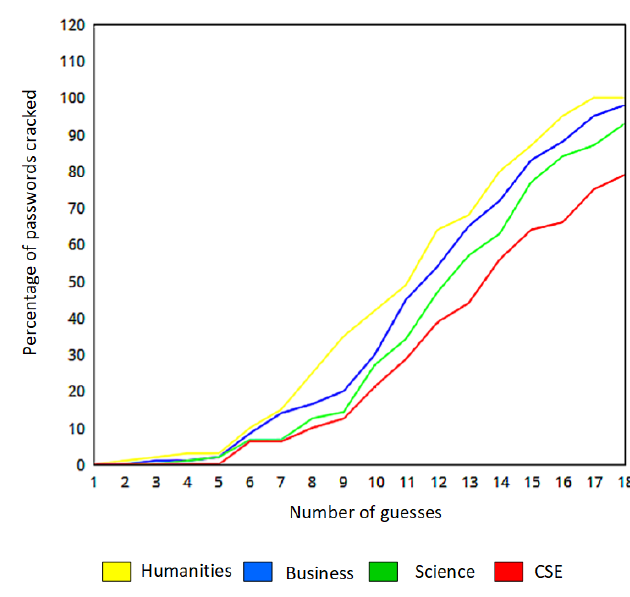
Figure 10. Student participants grouped in their respective subject of study